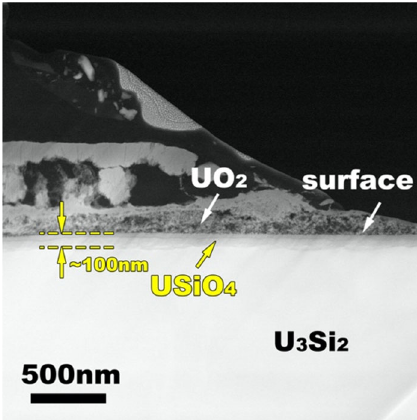
Fig. 2 Protective layer formed at the surface of U 3 Si 2 . TEM image of U 3 Si 2 and the newly formed USiO 4 and UO 2 . Note that the USiO 4 layer is dense and thin while UO 2 is porous